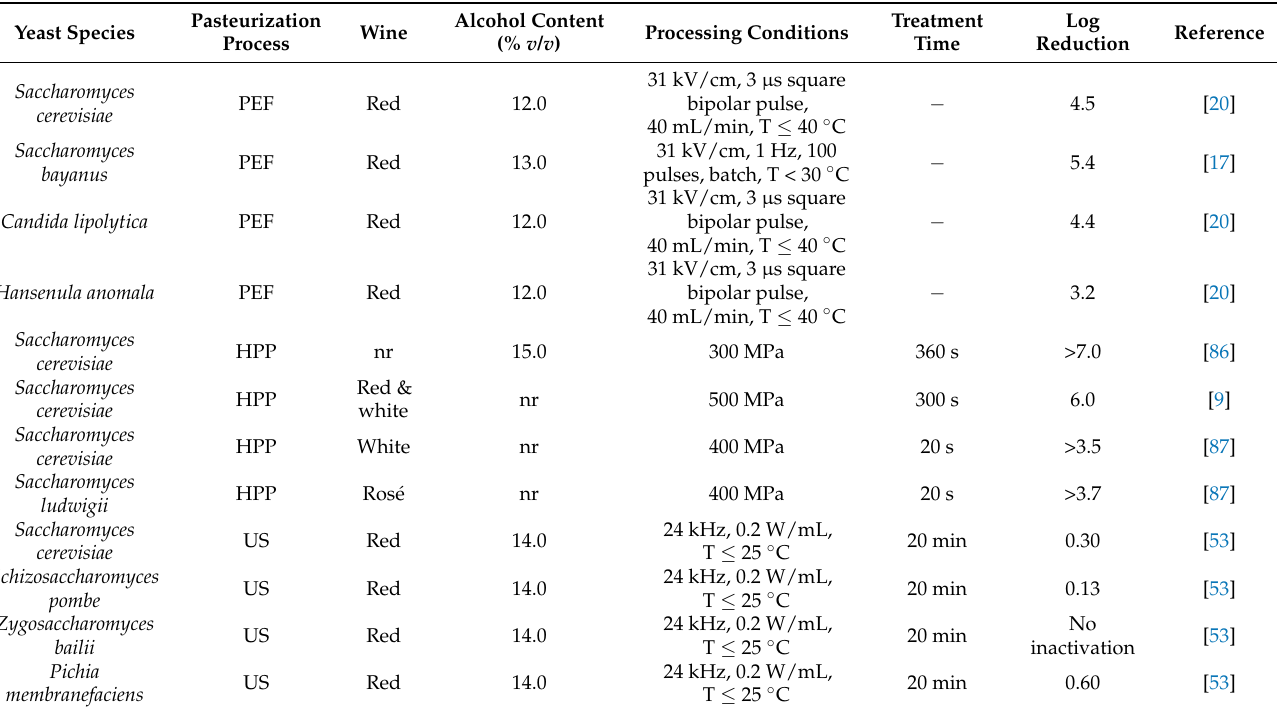
Table 2. Inactivation of different yeasts in wine by non-thermal PEF, HPP and US technologies *. Pasteurization Yeast Species